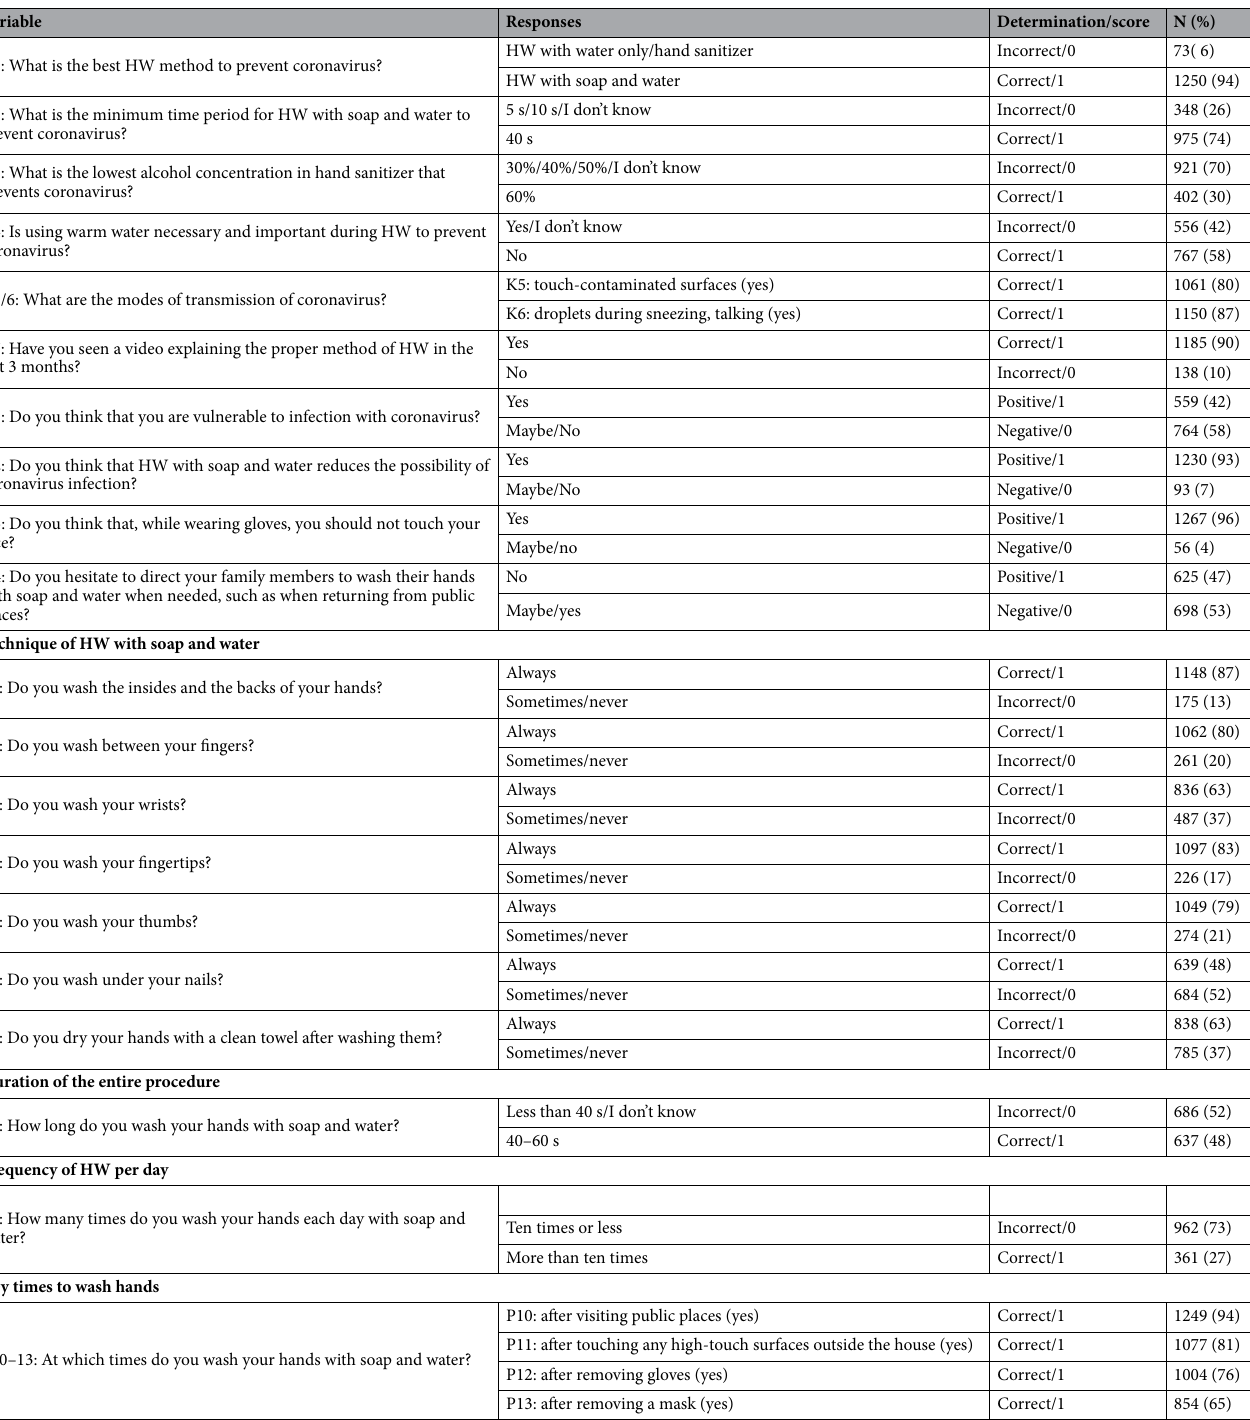
Table 2. Questionnaire on handwashing knowledge (K), attitudes (A), and practices (P) during the COVID- 19 pandemic in Saudi Arabia (n =